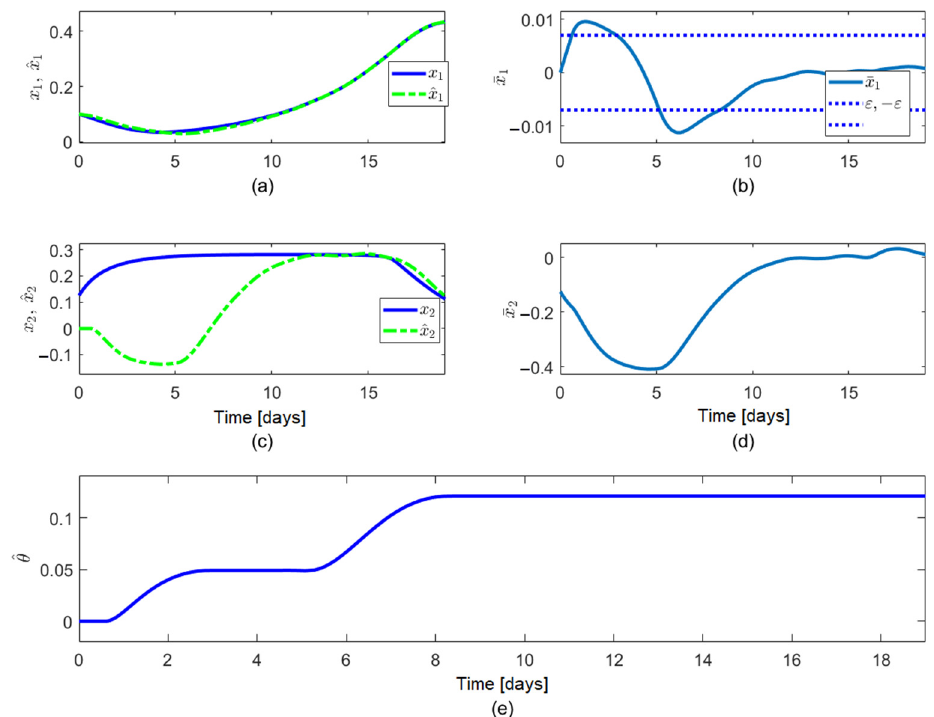
Figure 5. Performance of the proposed observer in the third simulation example: ( a ) trajectory of state x 1 and estimate ˆ x 1 ; ( b ) trajectory of the observer error for the known state, x 1 ; ( c ) trajectory of state x 2 and estimate ˆ x 2 ; ( d ) trajectory of the observer error for the unknown state, x 2 ; ( e ) trajectory of the updated parameter ˆ θ b